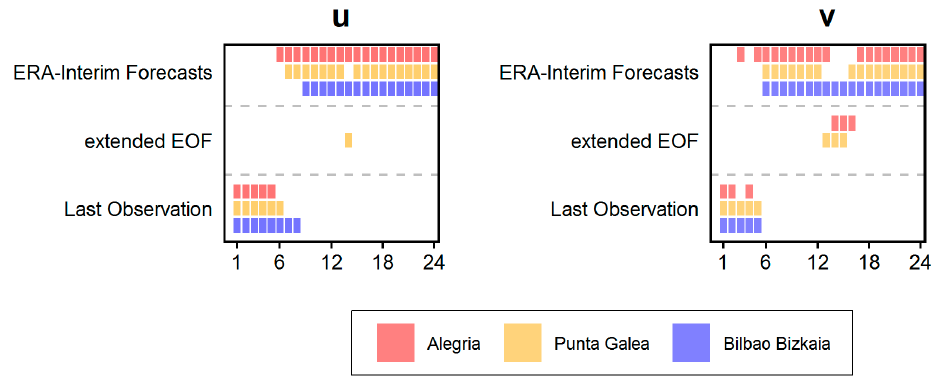
Figure 8. Most important input (last observation, extEOF, or ERA-I Forecast) of u and v wind components for the coming 24 h, at three locations using the RF method.